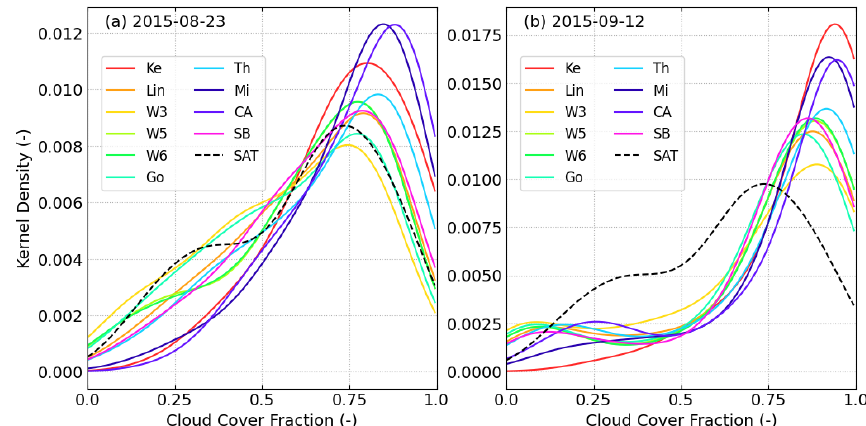
Figure 11. The probabilistic function from the kernel density estimation (KDE) of the average cloud fraction for the last 36h simulation for (a) case 23 August and (b) case 21 September. The PBL physics is by ACM2 and the cumulus parameterization is by Grell-3D. The solid color lines depict the KDE from the simulations, and the black dashed line is the KDE from the satellite data.